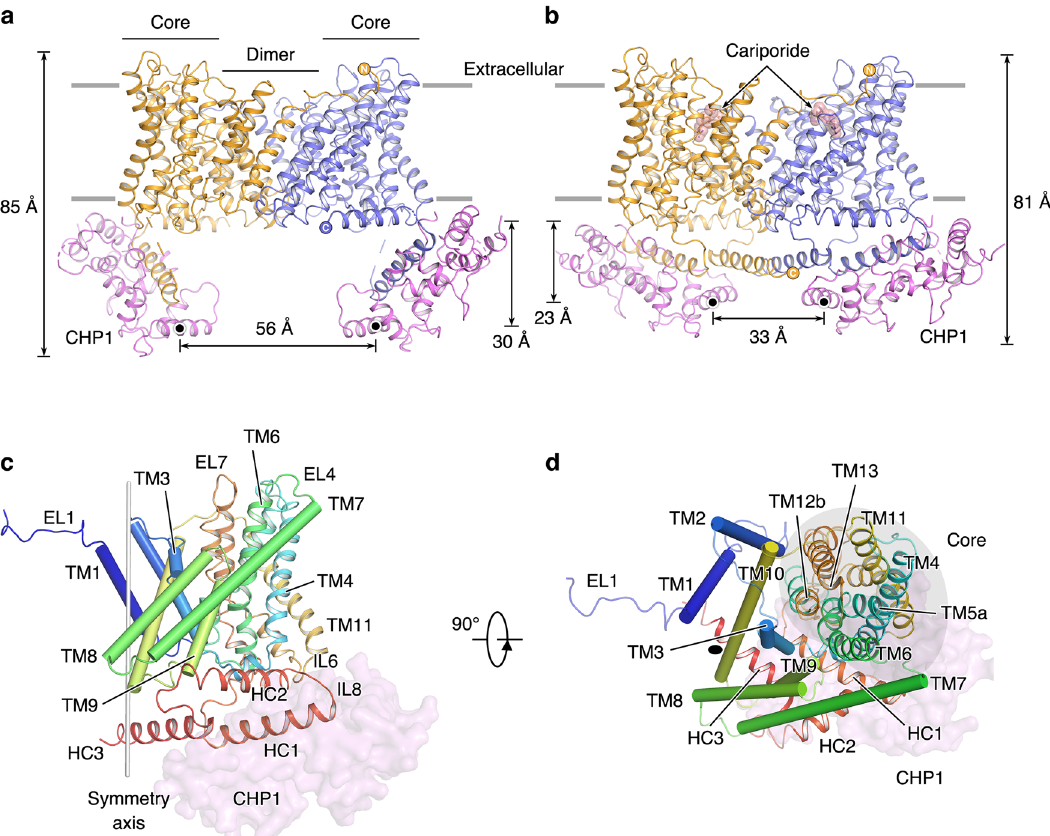
Fig. 1 Architecture of the NHE1-CHP1 complex. a , b Overall structures of the NHE1-CHP1 complex, in the absence and presence of cariporide, respectively. Two subunits of NHE1 are colored in orange and blue, and two CHP1 subunits are colored in magenta. Gray lines represent boundaries of the cell membrane. The black dots depict the centers of mass (COMs) of the E 4th helix of CHP1. The height of the complex and the distance between COMs are indicated. c , d Structure of the NHE1 protomer in the NHE1-CHP1 K/cariporide complex, viewed in the membrane plane and from the extracellular side, respectively. The peptide backbone of NHE1 is colored in a rainbow scheme, with blue and red for the amino and carboxyl termini, respectively. The core and dimerization domains are shown in cartoon and cylinder, respectively. The CHP1 molecule is displayed as a transparent pink surface model. 2-fold symmetry axis are depicted as a gray stick or black oval. The core domain is highlighted with a gray